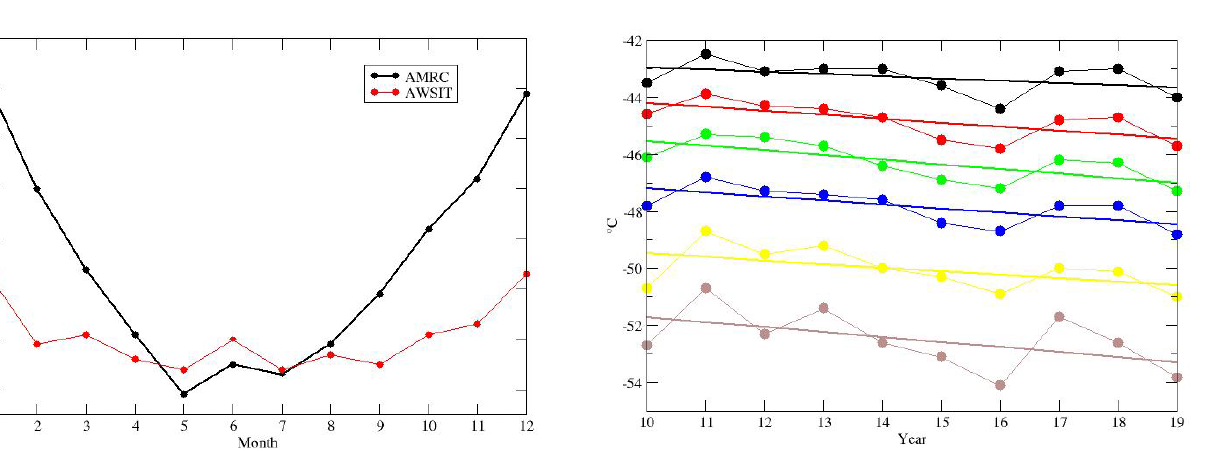
Figure 5. Temperature difference between the lowest temperature sensor on the Dome C tower ( ∼ 3m) and the nearby stations AMRC AWS (black) and AWSIT (red) ( ∼ 2m).